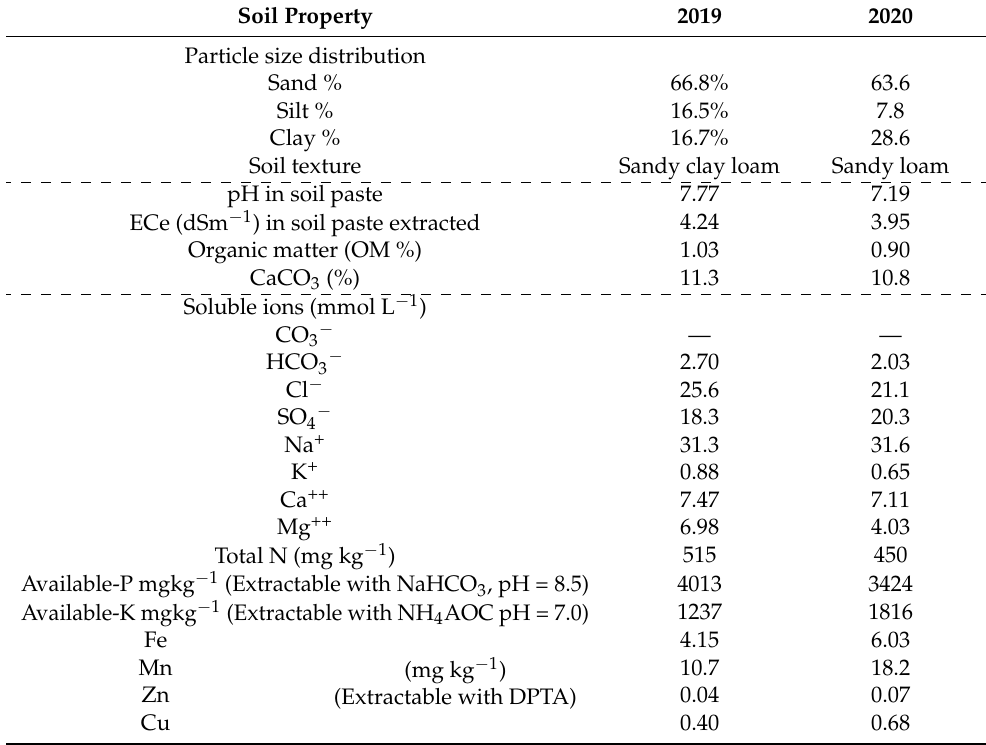
Table 3. Some soil physical and chemical